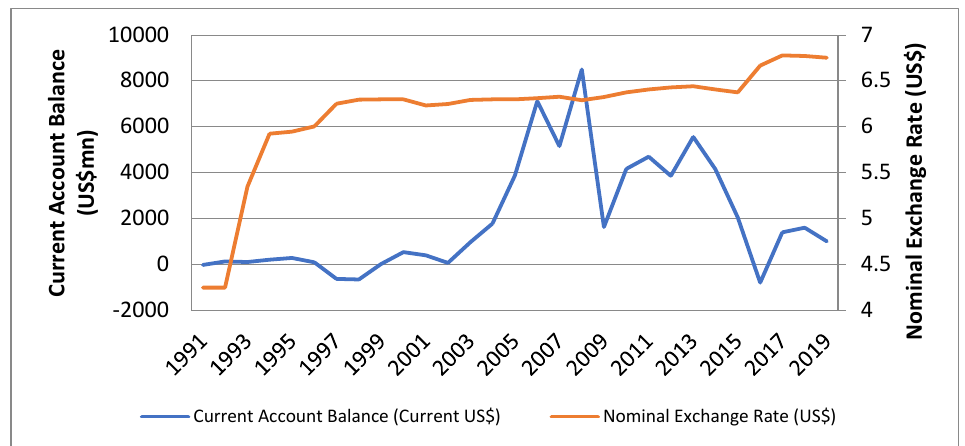
Figure 1. The relationship between the nominal exchange rate and current account balance for T&T over the period 1991-2019.